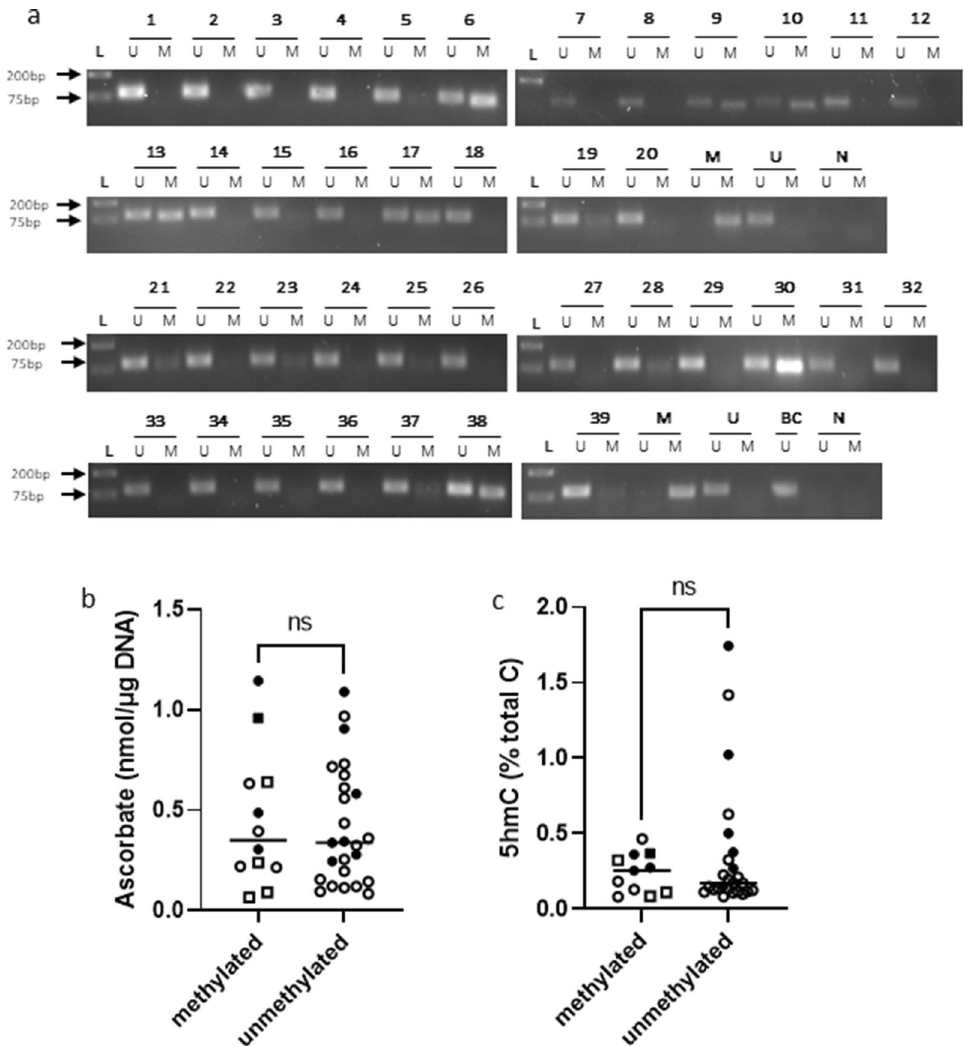
Figure 4. MGMT promoter hypermethylation status of clinical glioma samples. ( a ) Gel electrophoresis images of unmethylated (93 bp) and methylated (81 bp) MSP products for each glioma sample. The assay included an unmethylated (U), a methylated (M) positive control and a negative (N) control without DNA. Bisulfite conversion of all samples was performed simultaneously and the positive control reaction was visualised (BC). N = 39, including the two repeat samples (#24 and #36). ( b ) Association of ascorbate levels (nmol/µg/DNA) between gliomas with either unmethylated or methylated MGMT promoters. ( c ) Association of global 5-hmC (% of total cytosine) with unmethylated/methylated MGMT promoter. Filled circle WHO grade I-III, Open circle WHO grade IV, Square samples with apparent low methylation; median is shown as horizontal line, n =